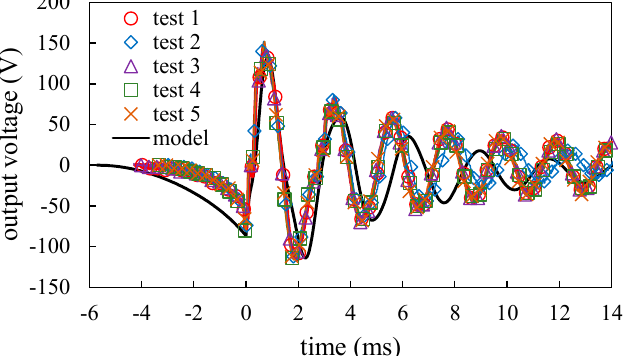
Figure 11. The comparisons of the open-circuit voltage responses of the PEH obtained by experiments and the dynamic model.